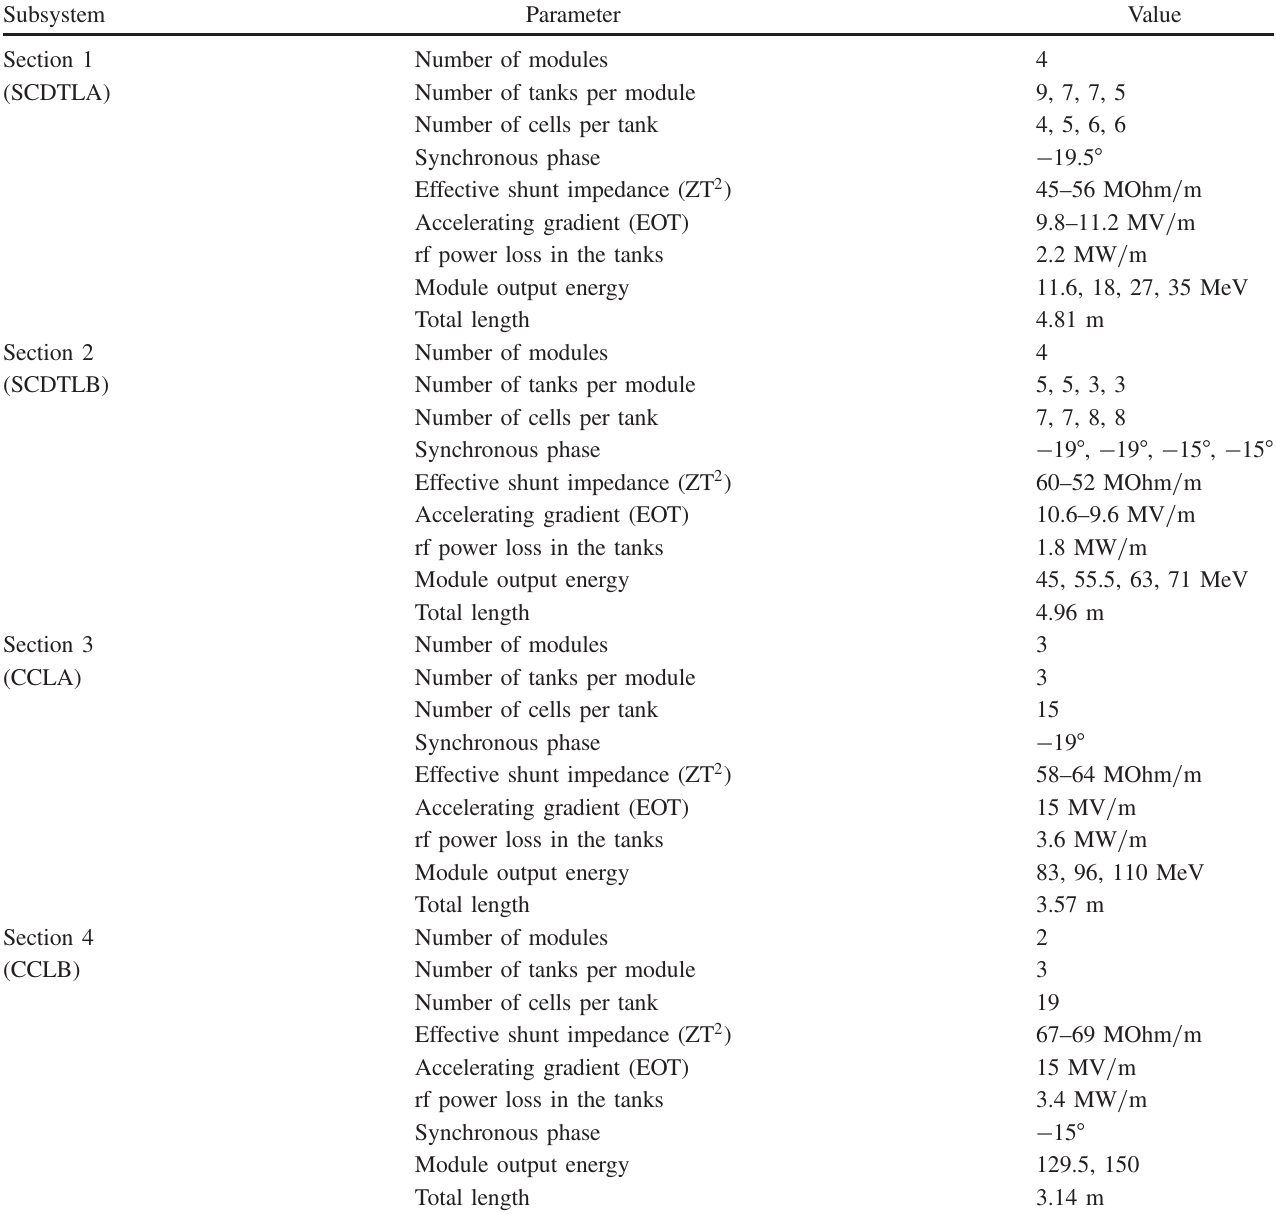
TABLE I. Main design parameters of the TOP-IMPLART high-frequency (2997.92 MHz)